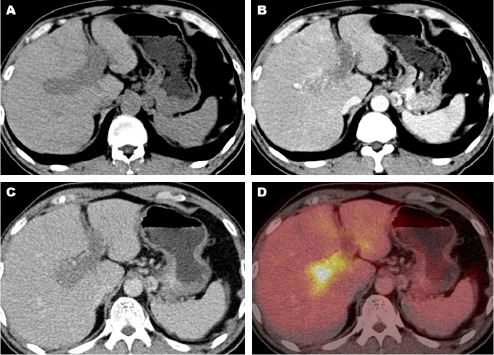
The contrast-enhanced FDG PET/CT image shows the expansion of right and left portal veins with hypodense intraluminal thrombus in non-enhanced CT scan (A). The thrombus in the right branch showed a linear contrast enhancement in the arterial phase CT (B). The thrombus appeared washout in the portal venous phase CT (C), and showed an increased FDG uptake in the PET/CT image (D)